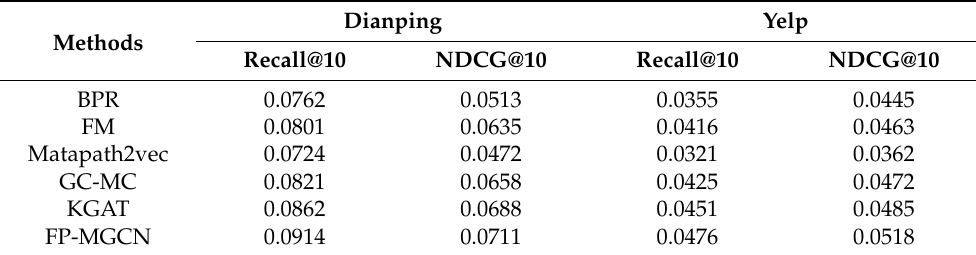
Table 2. Performance of approaches on Dianping and Yelp.